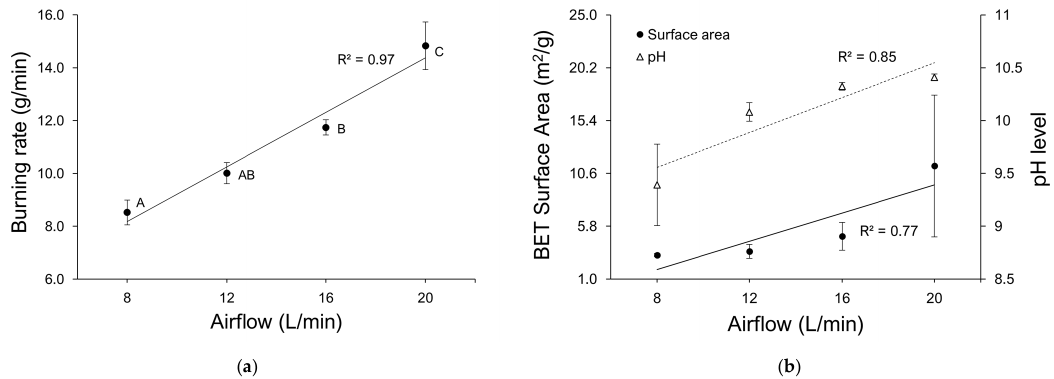
Figure 3. Airflow effect on: ( a ) gasification burning rate; ( b ) wild sugarcane biochar pH and BET surface area. Different letters indicate a significant difference.